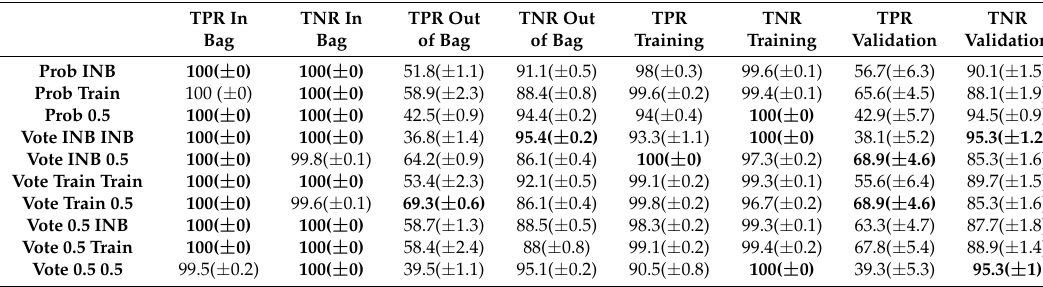
Table A2. TPR and TNR for Ventricular